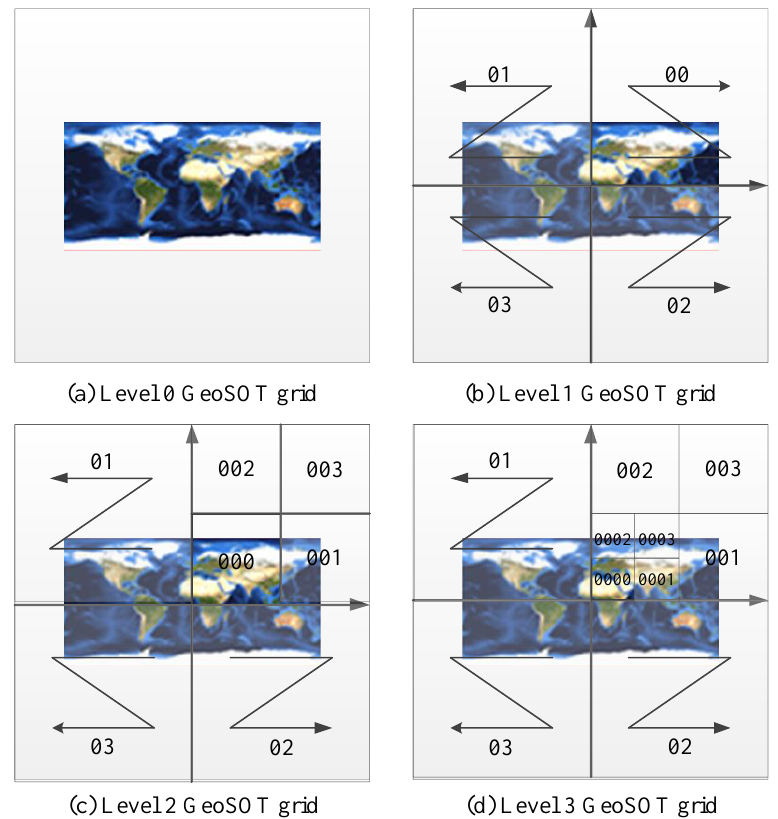
Figure 3. Level 0–3 Geographical Coordinate Subdividing Grid with One Dimension Integer Coding on 2 n Tree (GeoSOT) grids.